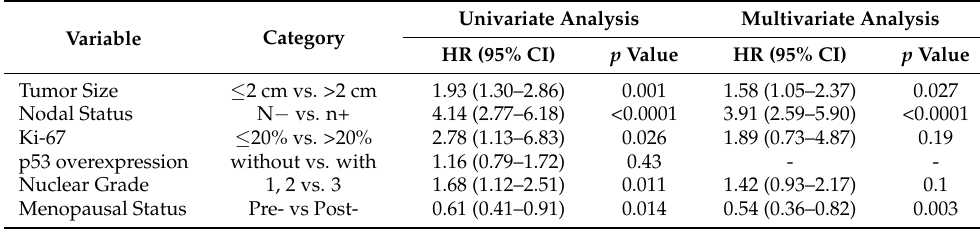
Figure 2. DFS according to Menopausal Status and Ki-67 Index Value in TNBC. There was no difference in DFS between the menopausal status in cases with a high Ki-67 index value ( ≥ 50%). On the other hand, in the cases with a low Ki-67 index value (<50%), the postmenopausal patients had a significantly higher DFS rate. Table 5. Uni- and Multivariate Analysis of Factors for DFS in Triple Negative Breast Cancer.